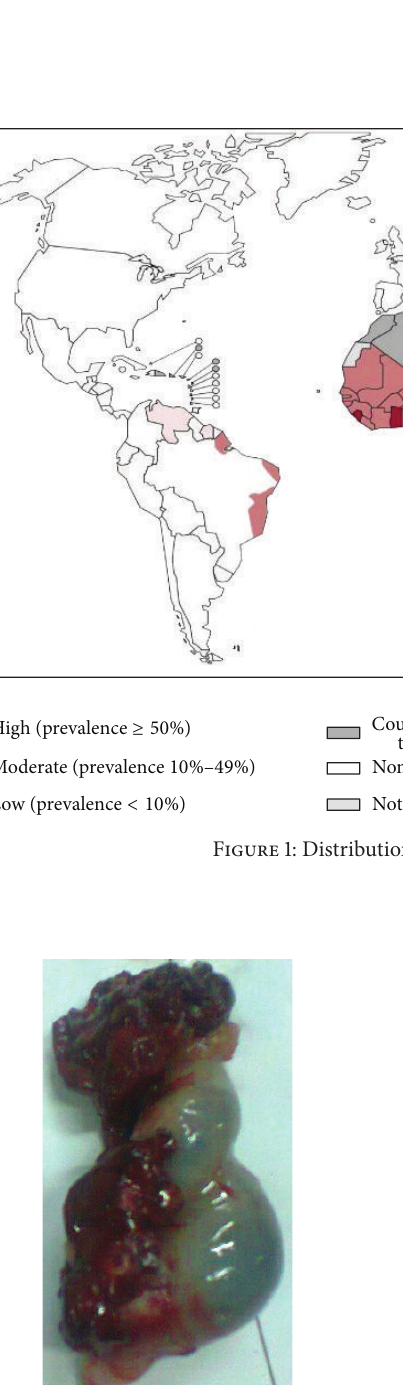
Figure 2: Ruptured right fallopian tube. Figure 3: Bulbous left fallopian